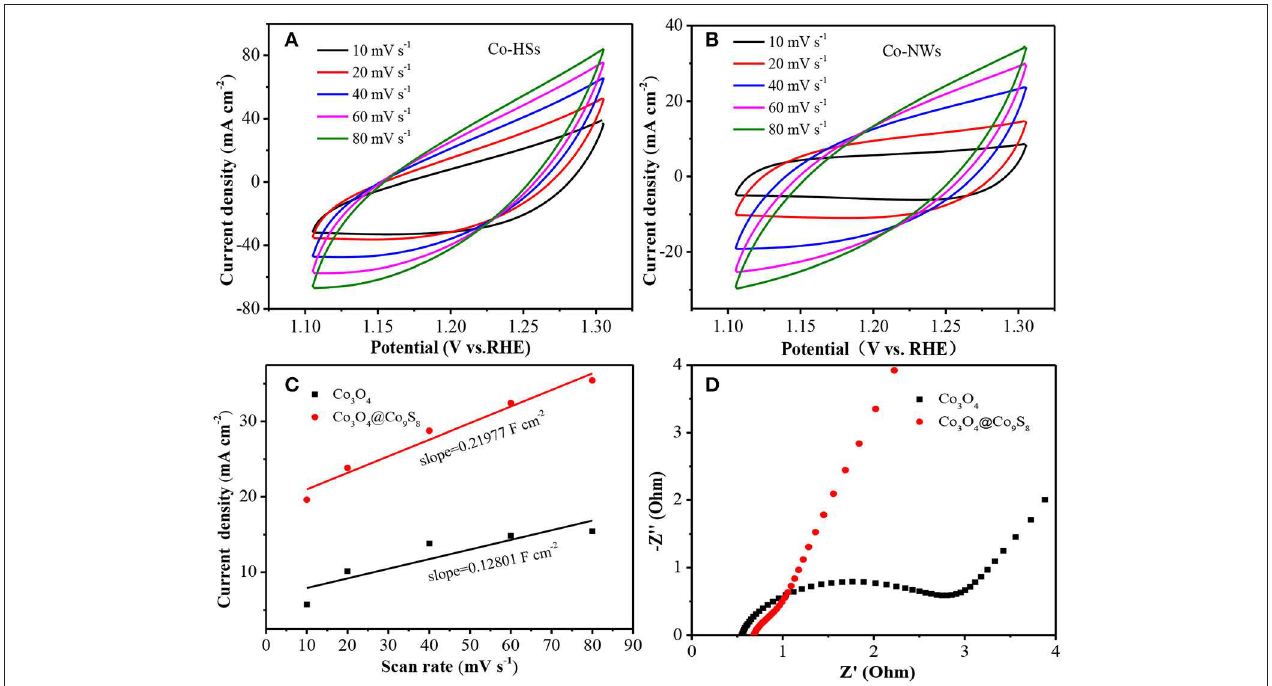
FIGURE 3 | Electrochemical measurements of Co-NWs and Co-HSs, (A) CV curves, (B) CV curves, (C) CV fitting curves, and (D) EIS